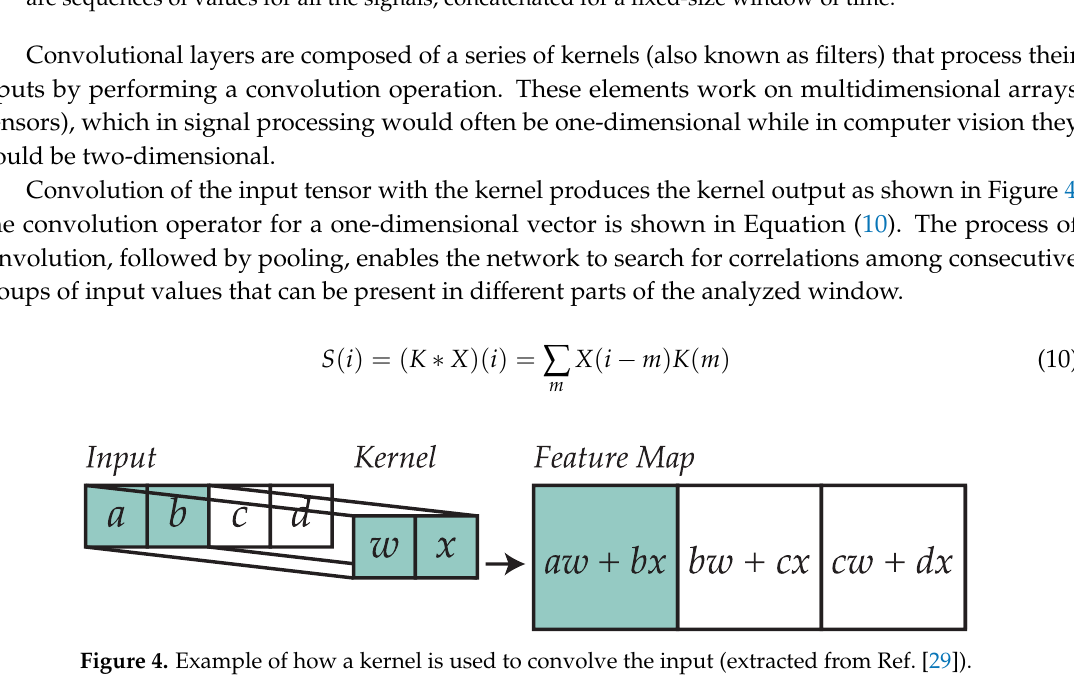
Figure 3. Common topology of a CNN (extracted from Ref. [29]). For signal processing, input vectors are sequences of values for all the signals, concatenated for a fixed-size window of time.